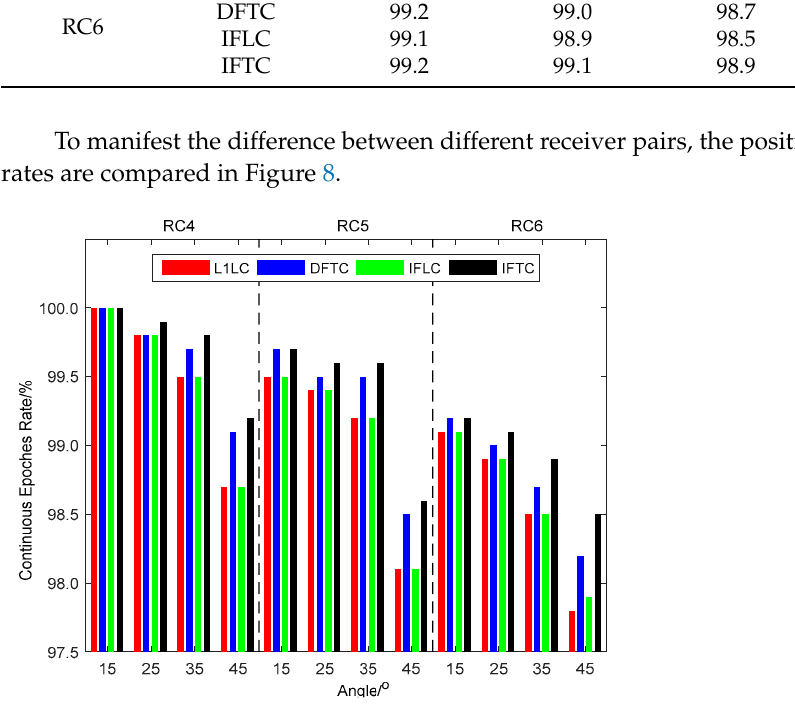
Figure 8. Positioning continuity epochs results with different cutoff elevation angles. The columns from left to right correspond to receiver pair RC4, RC5 and RC6, respectively. In the L1TC part, the columns from left to right are the cutoff elevation angles 15°, 25°, 35°, and 45°, respectively. The other parts are also the same as L1TC part. Note that the P c of L1TC, DFTC, IFLC, and IFTC are represented by red bars, blue bars, green bars, and black bars.